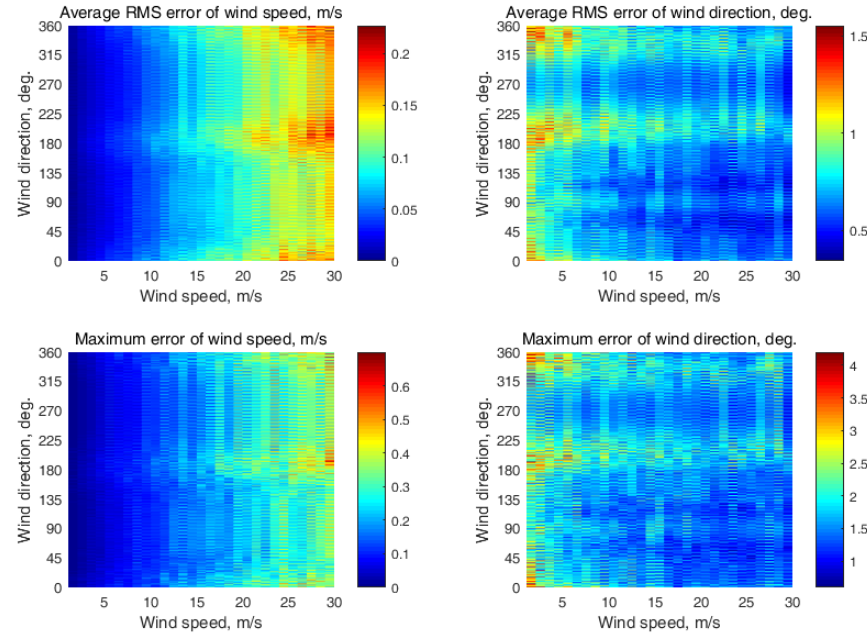
Figure A7. Semicircular wind retrieval results at a single 55° incidence angle.